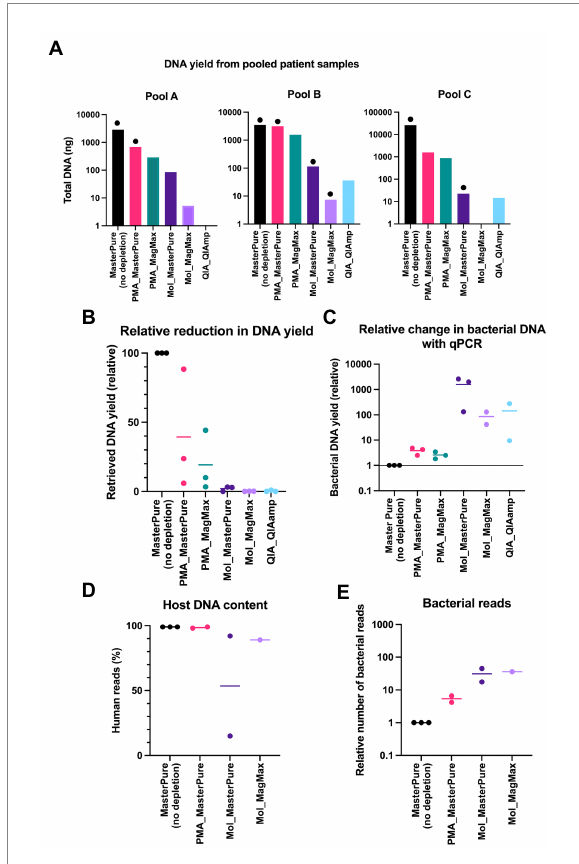
FIGURE 3 Pooled patient samples. (A) DNA yield extracted from pools A, B, and C according to different protocols. Each bar represents DNA yield of one sample. Samples that proceeded to WMS are marked with black dots (library concentration > 10 nM). (B) Comparison of relative reduction in total DNA yield with protocols for DNA depletion. MasterPure (no depletion) was used as a reference. (C) Relative change in the proportion of microbial DNA/host DNA, evaluated with real-time qPCR. (D) Host DNA content evaluated with WMS in samples from patients’ pools A, B, and C. MasterPure protocol served as a reference. (E) Increase in number of bacterial reads in depleted samples, relative to non- depleted reference samples. (B–E) Values for individual samples are presented as dots. Bars correspond to mean values